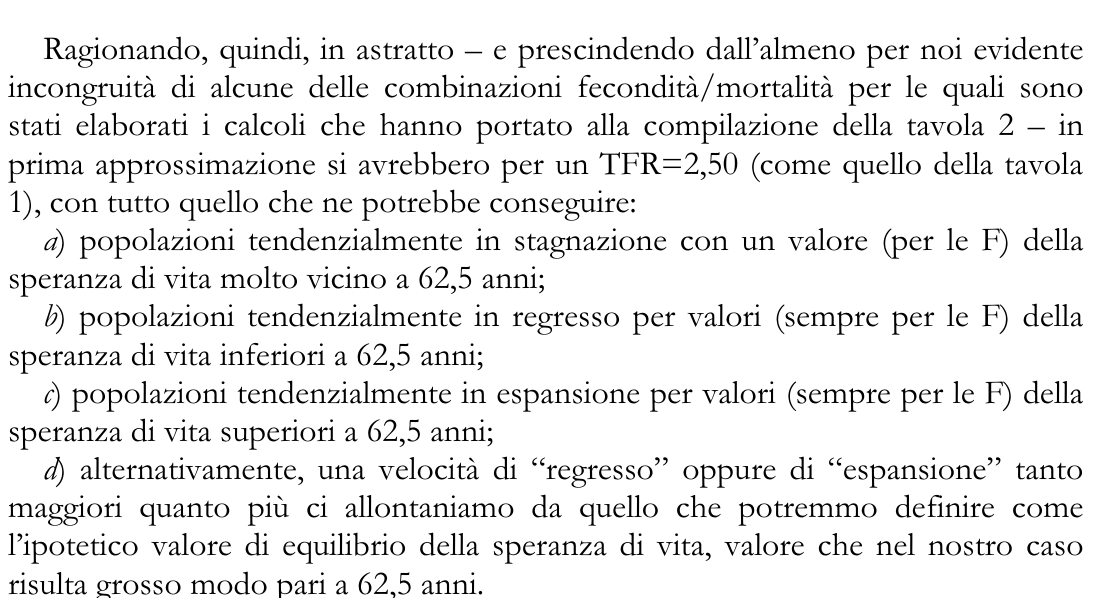
Figura 1 – Valori dei tassi netti di riproduzione totale (R 0 ) in corrispondenza di un tasso lordo di ri- produzione totale (TFR) pari a 2,50 in funzione di differenti valori della vita media alla nascita (Ta- vole di Coale e Demeny: modello